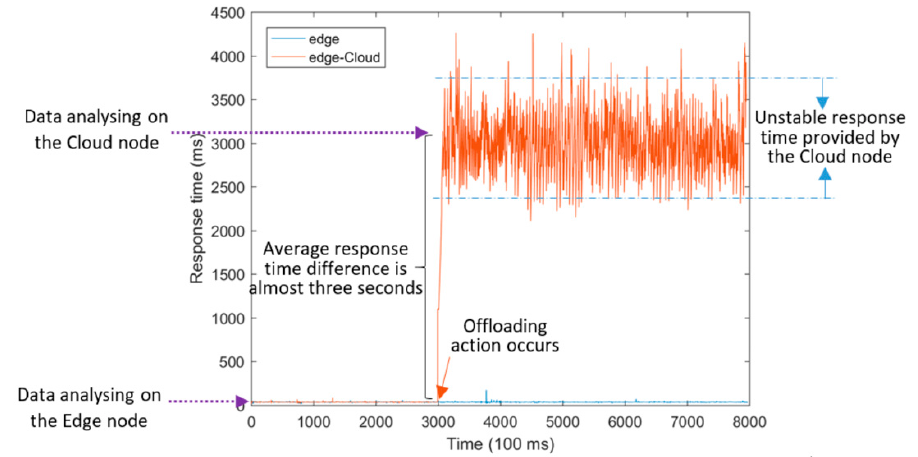
Figure 11. Service response time provided by the unintelligent method.